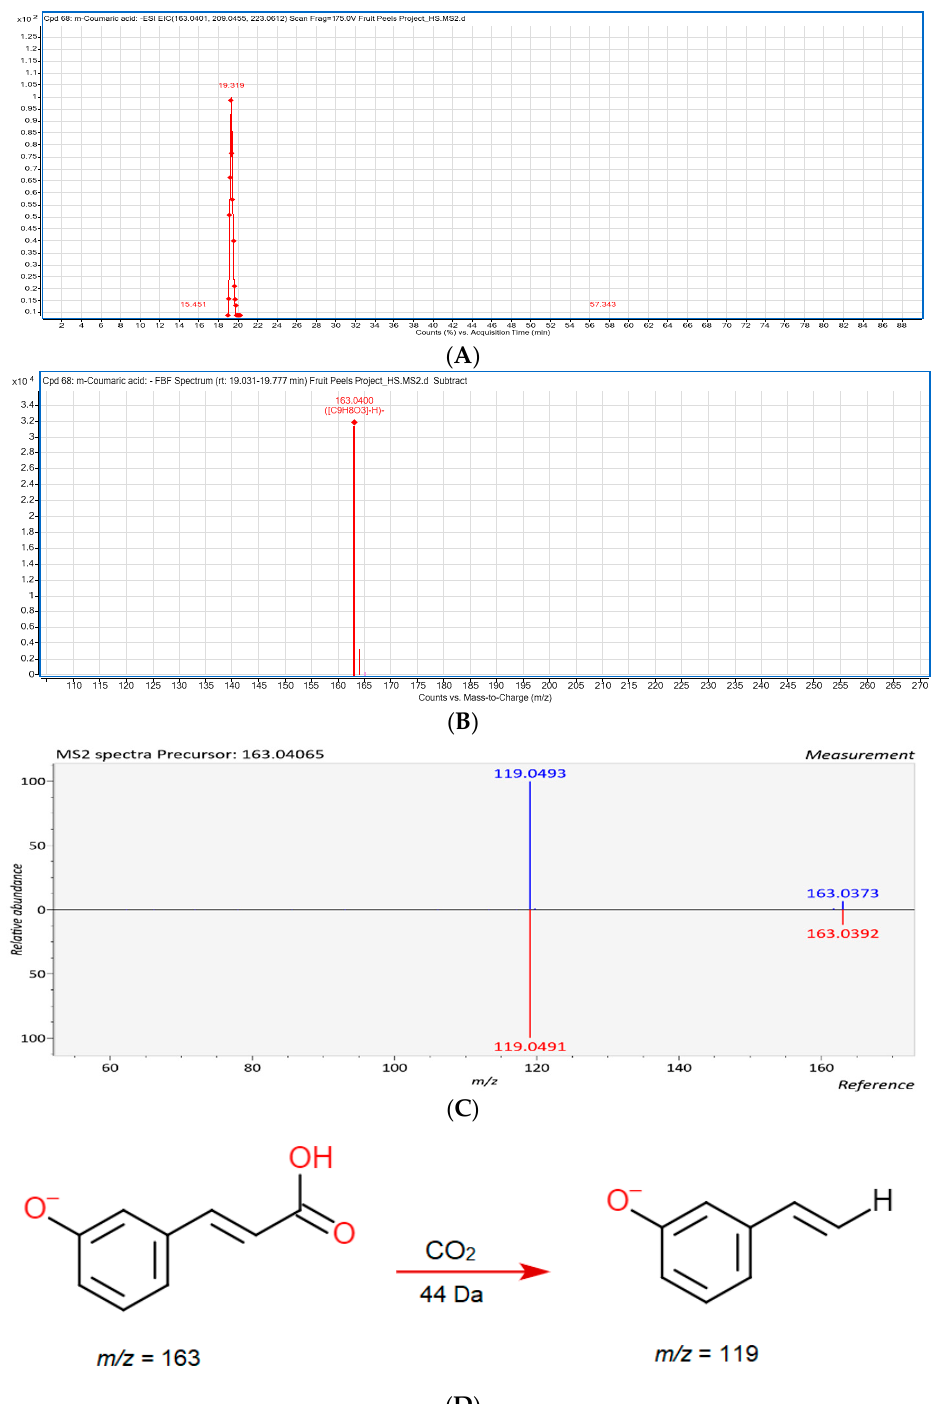
Figure 2. The LC-ESI-QTOF-MS / MS characterization of m -coumaric acid. ( A ) A chromatograph of m -coumaric acid (Compound 25, Table S1—Supplementary Data) in the negative mode [M − H] − which was tentatively identified and characterized in fifteen di ff erent fruit peel samples; ( B ) a mass spectrum of m -coumaric acid with a precursor of m / z 163.0406 in the apple peel; ( C ) MS / MS spectrum of m -coumaric acid with the product ion of m / z 119 (confirmed from online LC-MS library and database); ( D ) a fragmentation pattern of the m -coumaric acid in negative mode [M − H] − , with precursor of m / z 163 and a product ion of m / z 119 due to the loss of CO 2 .